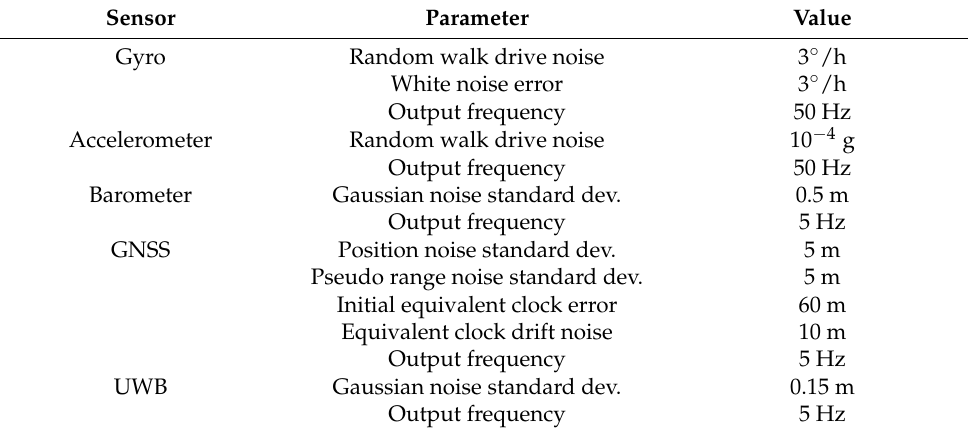
Table 1. Sensor configuration and parameters.